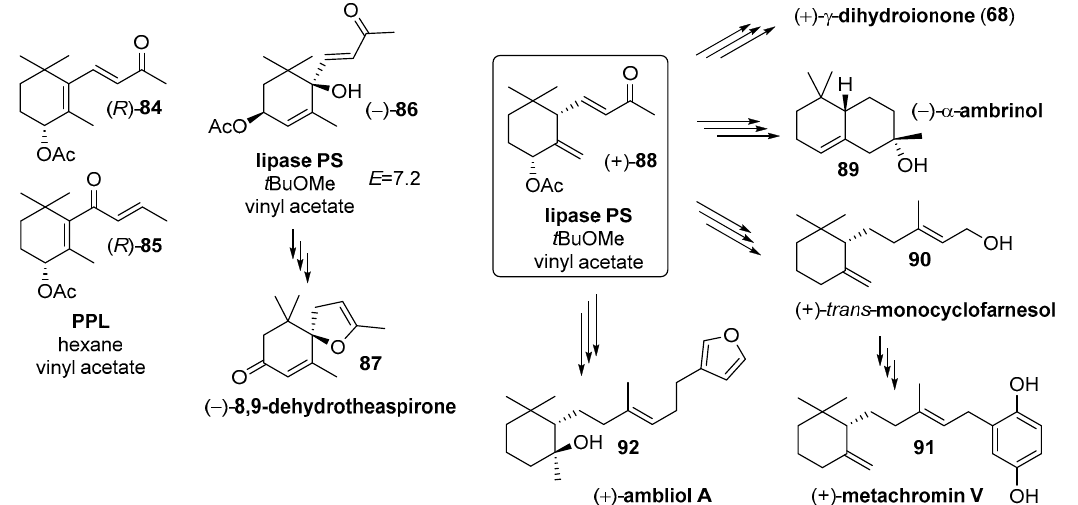
Figure 15. Lipase-mediated resolution of the racemic apocarotenoid precursors possessing a cyclic secondary alcohol in their frameworks. Application to the synthesis of norterpenoids 4-acetoxy- β -ionone ( 84 ), 4-acetoxy- β -damascone ( 85 ), 8,9-dehydrotheaspirone ( 87 ), γ -dihydroionone ( 68 ), α -ambrinol ( 89 ), and the terpenoids trans -monocyclofarnesol ( 90 ), metachromin V ( 91 ), and ambliol A ( 92 ).